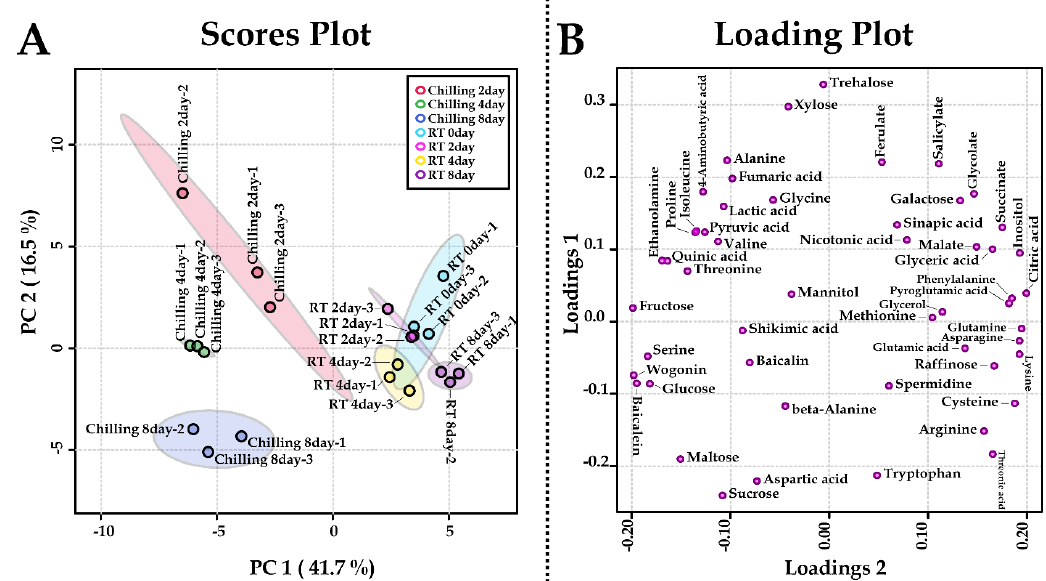
Figure 2. Scores ( A ) and loading ( B ) plots of the PCA model using metabolites from the roots of S . baicalensis plantlets treated with chilling. RT, room temperature (25 °C); ferulate, ferulic acid; succinate, succinic acid; salicylate, salicylic acid; malate, malic acid.